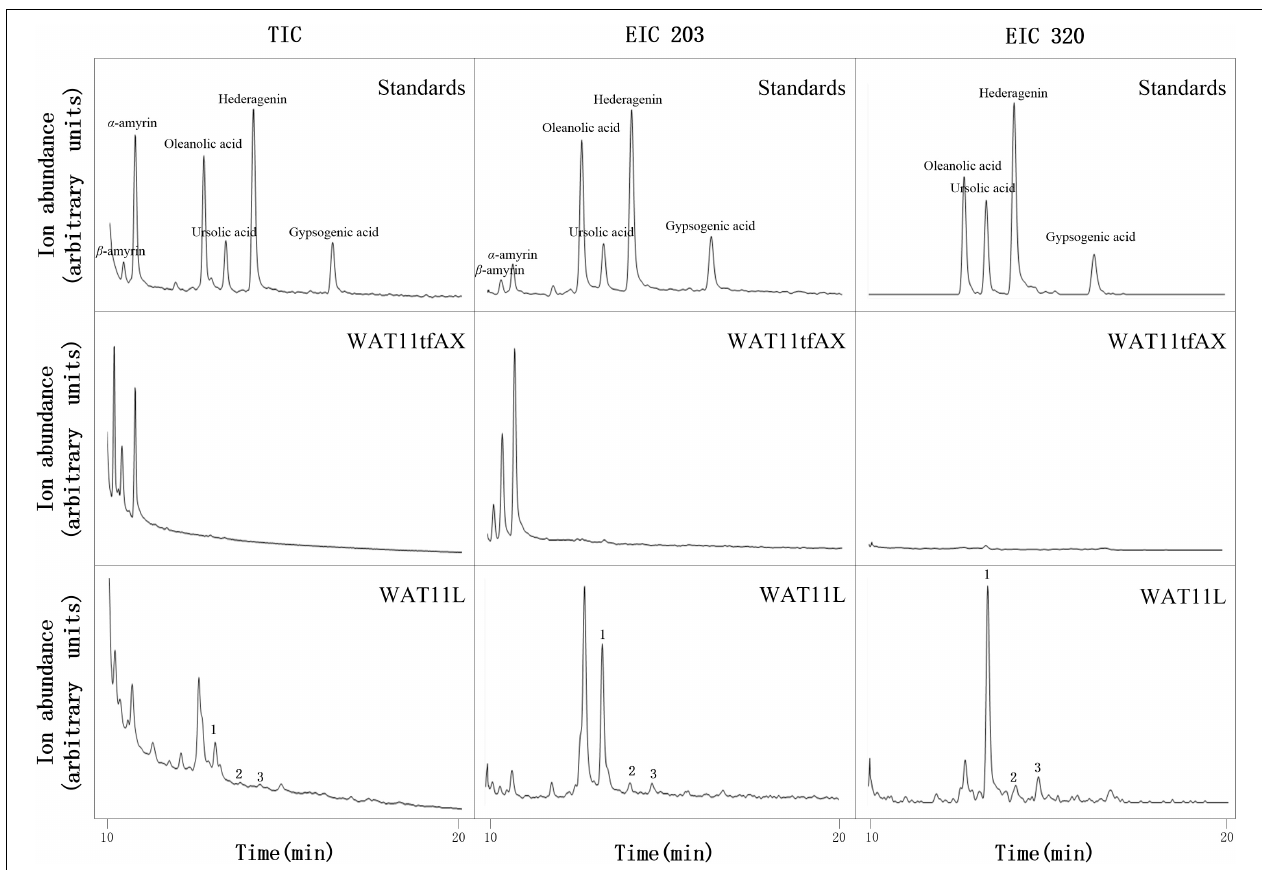
FIGURE 9 | GC-MS analysis of metabolites in WAT11L. The total ion flow diagram of mixed standard, control yeast strain WAT11tfAX and WAT11tfAX-derived strain WAT11L were marked separately in the figure. In TIC mode analysis, compared with WAT11tfAX, WAT11L generated three new peaks 1, 2, and 3. The retention time of peak 1 and 2 in WAT11L compared well with those in mixed standard. In single ion mode ( m/z 203, 320), the peak of 1, 2, and 3 were more obvious. In addition, the GC retention time difference between peaks 2 and 3 of the two compounds matched the retention time difference between ursolic acid and oleanolic acid.